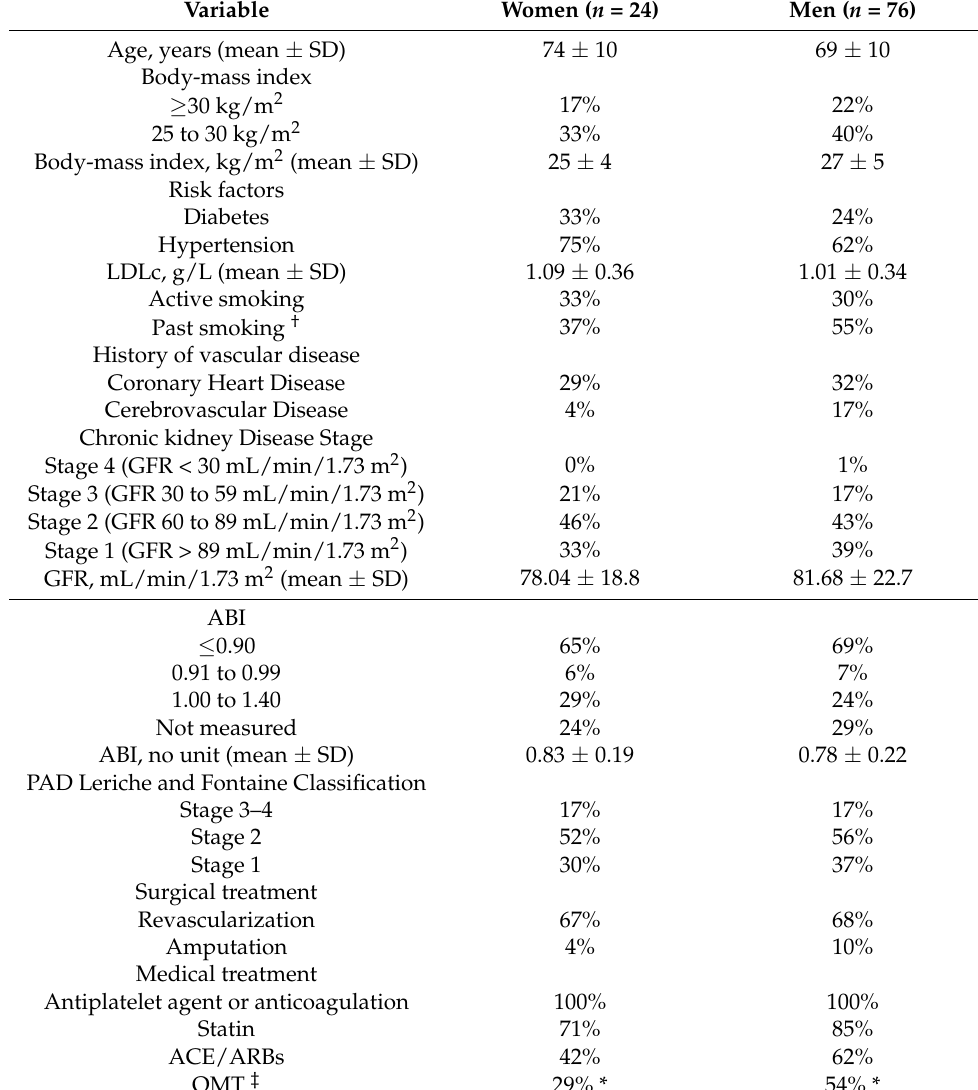
Table 2. Gender differences in risk factors, presentation and management of peripheral vascular disease.